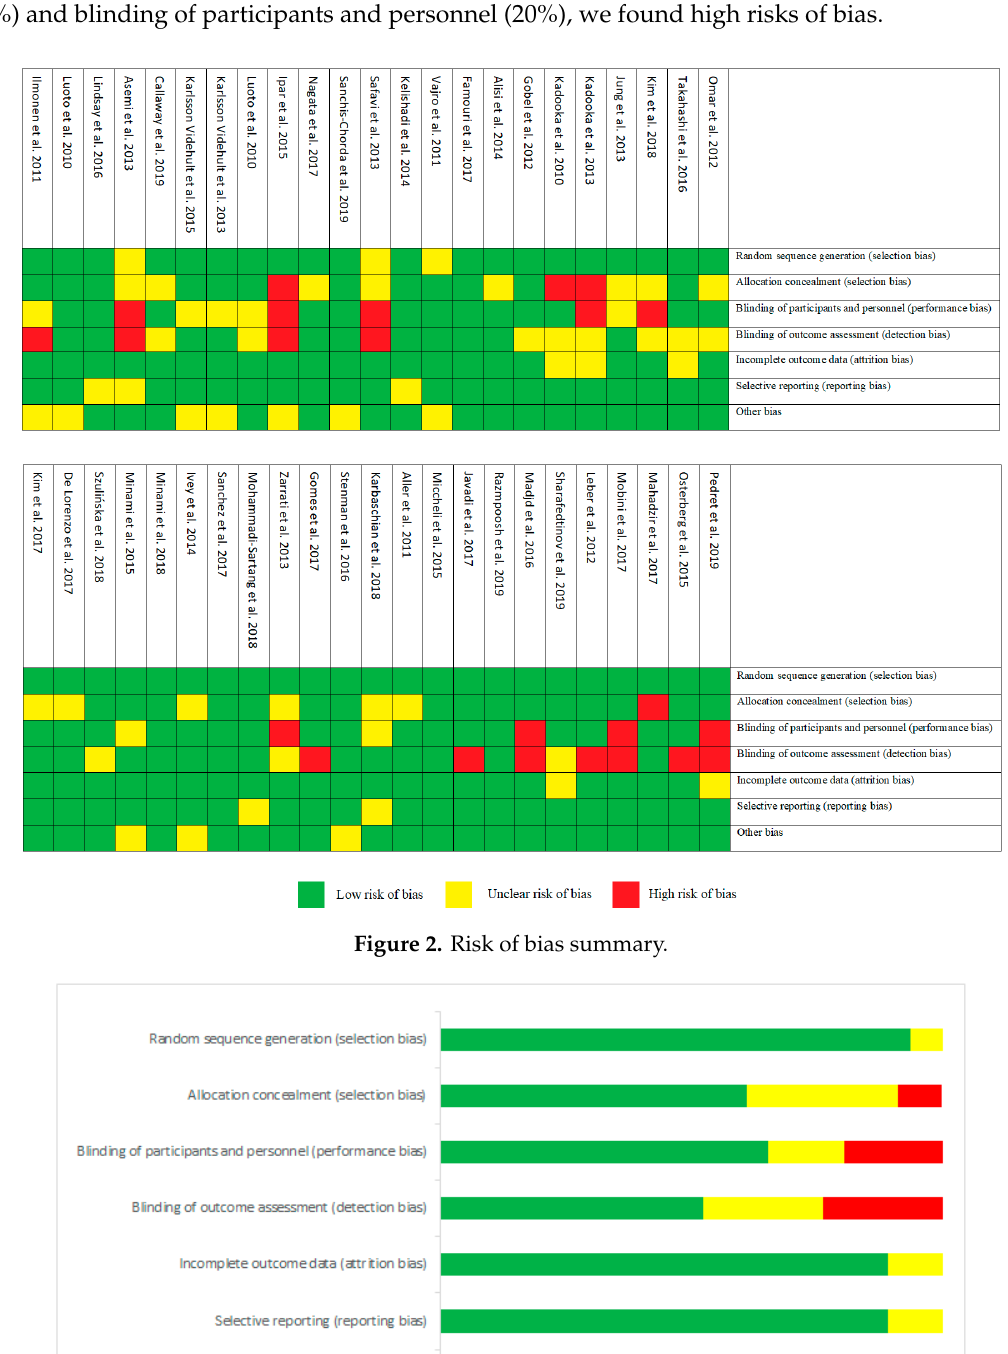
Figure 3. Risk of bias graph.